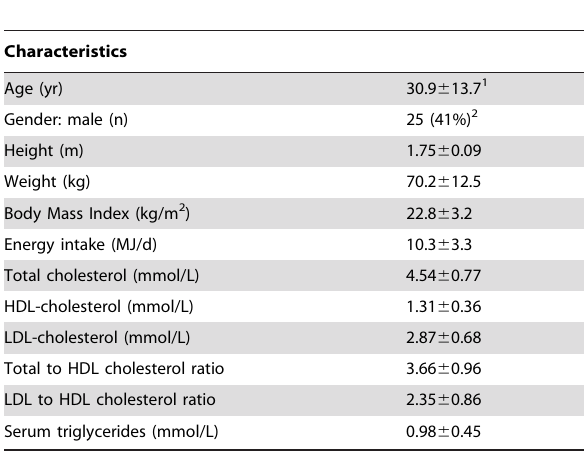
Table 2. Baseline characteristics at the pre-study screening of all subjects who completed the study